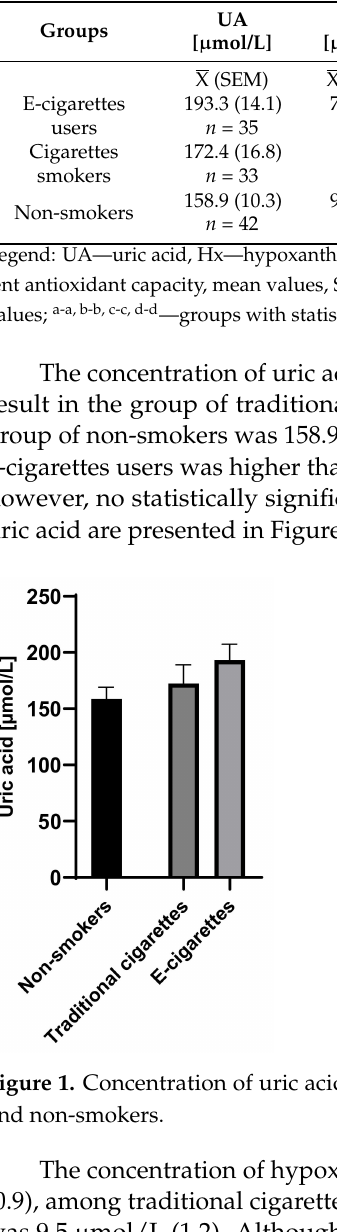
Table 1. Mean values of uric acid, hypoxanthine, xanthine, uric acid + xanthine, TAOS and TEAC on unstimulated saliva among e-cigarette users, cigarette smokers and non-smokers.